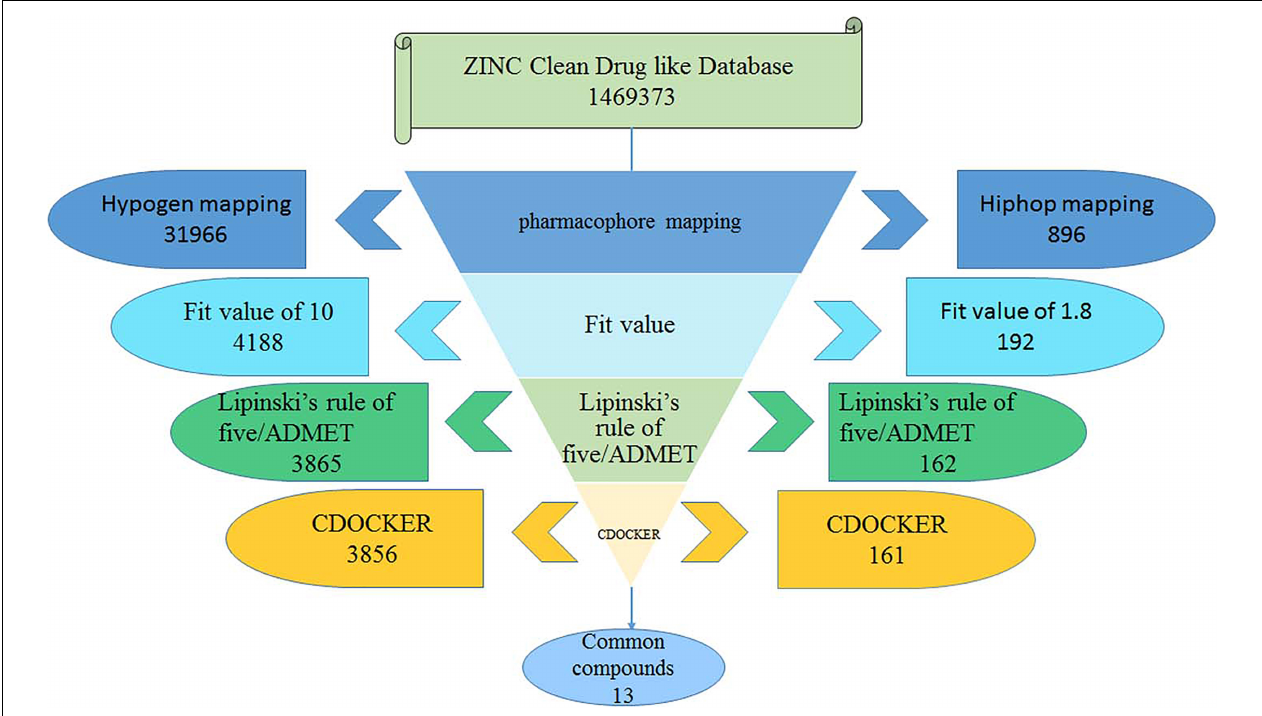
FIGURE 1 | The flow chart for the virtual screening